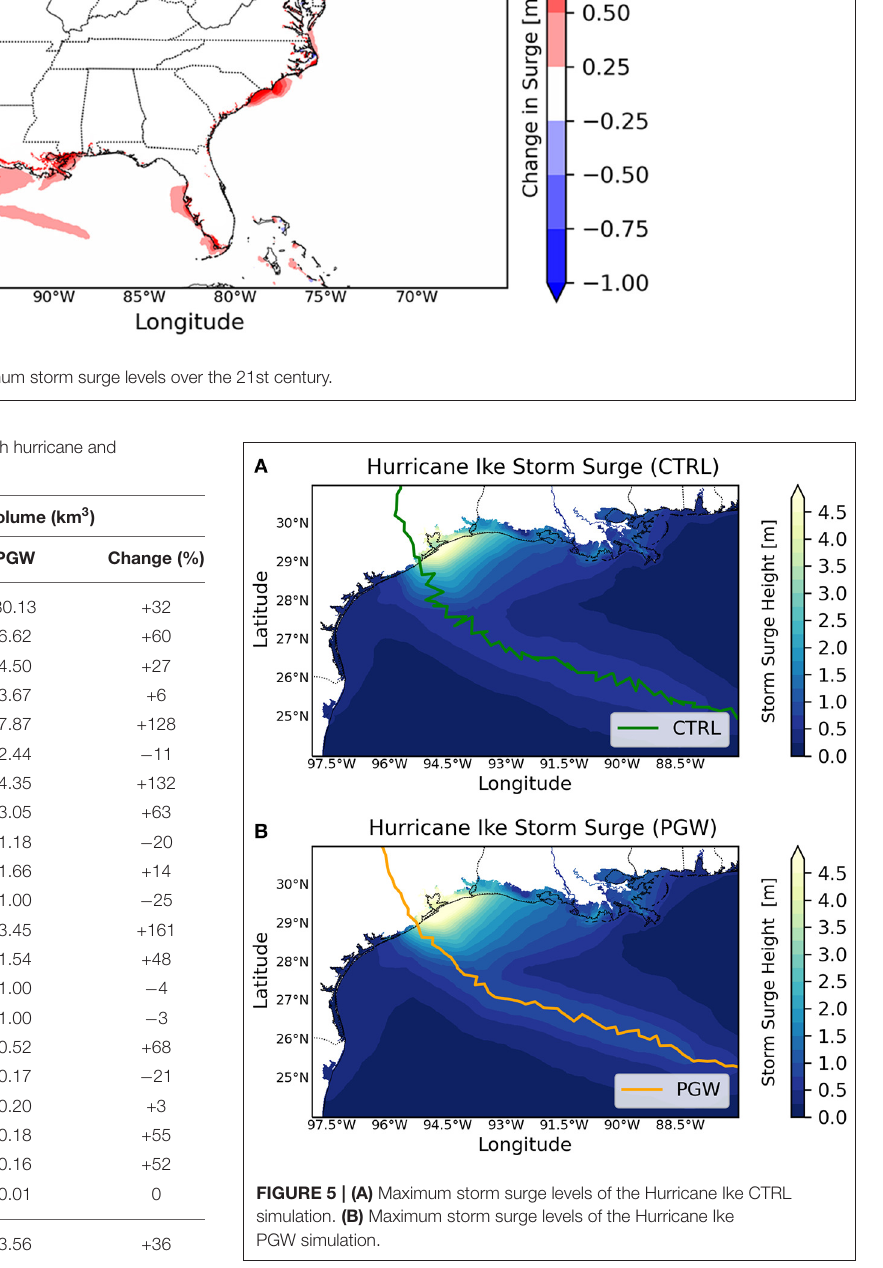
FIGURE 5 | (A) Maximum storm surge levels of the Hurricane Ike CTRL simulation. (B) Maximum storm surge levels of the Hurricane Ike PGW